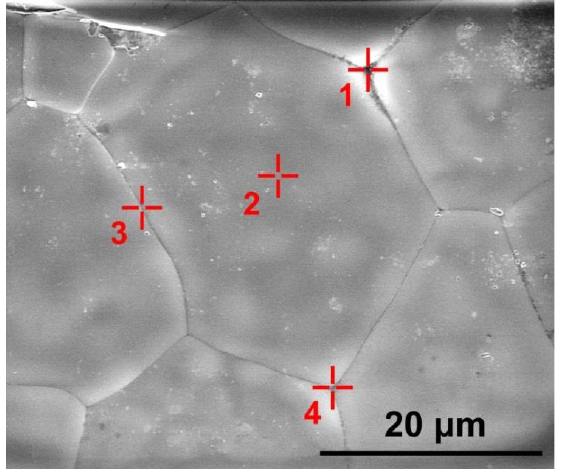
Figure 5. SEM image of the (ZrO 2 ) 0.909 (Y 2 O 3 ) 0.09 (Eu 2 O 3 ) 0.001 ceramic specimen synthesized using slip casting. The symbols show areas (1, 2, 3, 4) in which the ZrО 2 , Y 2 О 3 and Al 2 О 3 oxide concentra- tions were measured. Table 2. Elemental analysis data for (ZrO 2 ) 0.909 (Y 2 O 3 ) 0.09 (Eu 2 O 3 ) 0.001 ceramics synthesized using slip casting. Area Concentration, mol.% ZrО 2